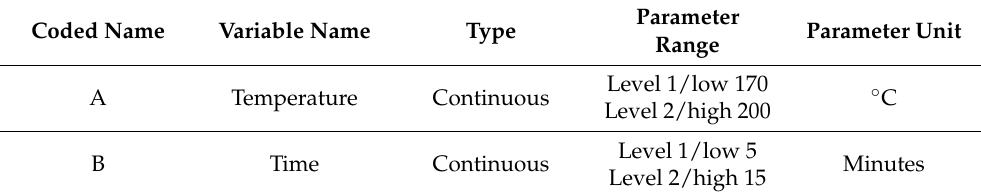
Table 1. The parameter ranges selected for the study using